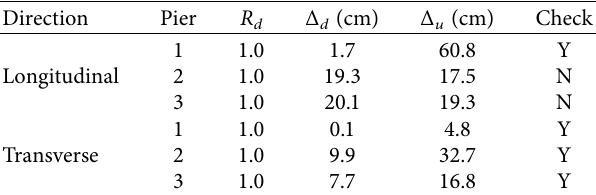
Table 6: Checking of displacement capacity of piers. Direction Pier R d Δ d (cm) Δ u (cm) Check Longitudinal